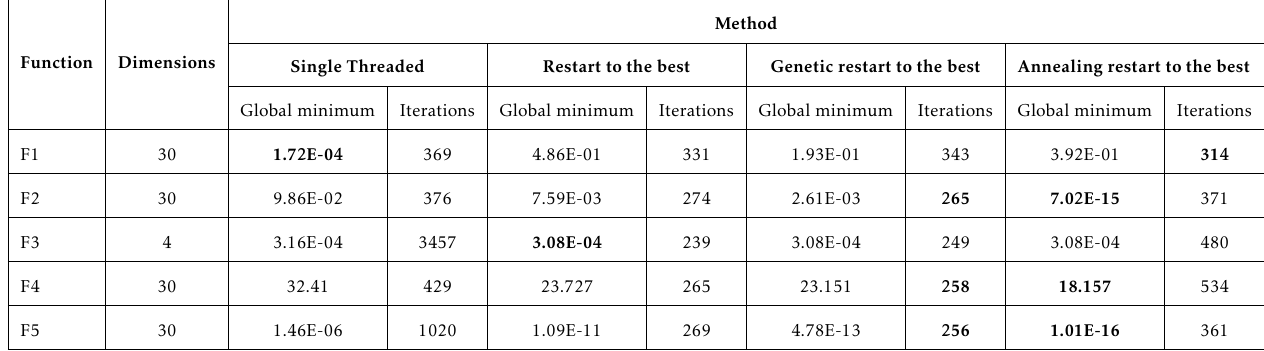
Table 6. Comparison of the benchmark results obtained by RFO between the different approaches